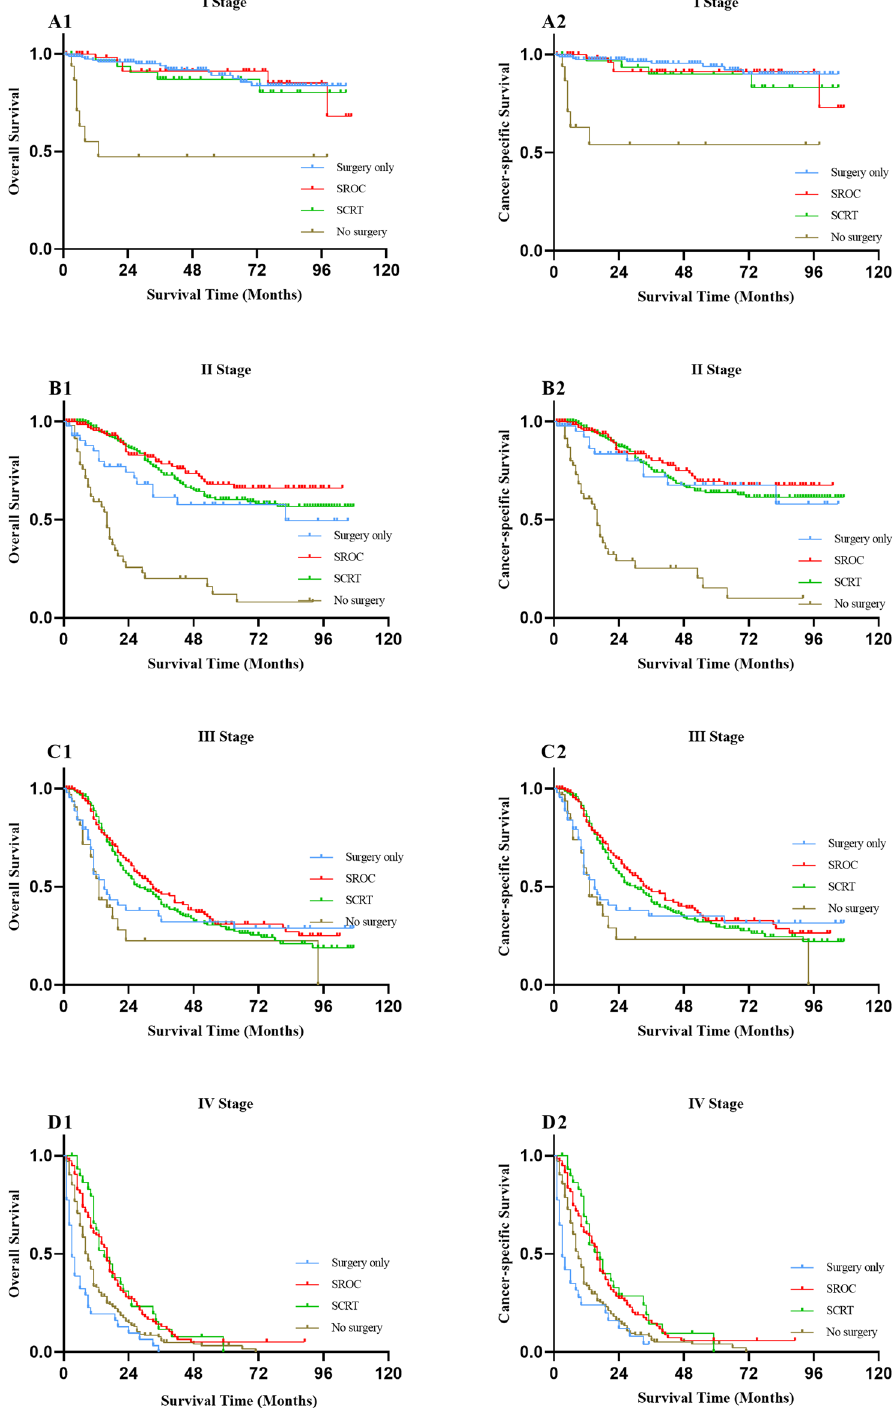
Figure 4. Kaplan–Meier survival curves for overall survival ( A1 , B1 , C1 , D1 ) and cancer-specific survival ( A2 , B2 , C2 , D2 ) in patients with TNM stage I, II, III, IV undergoing different treatments respectively. SROC, surgery plus radiotherapy or chemotherapy; SCRT, surgery plus